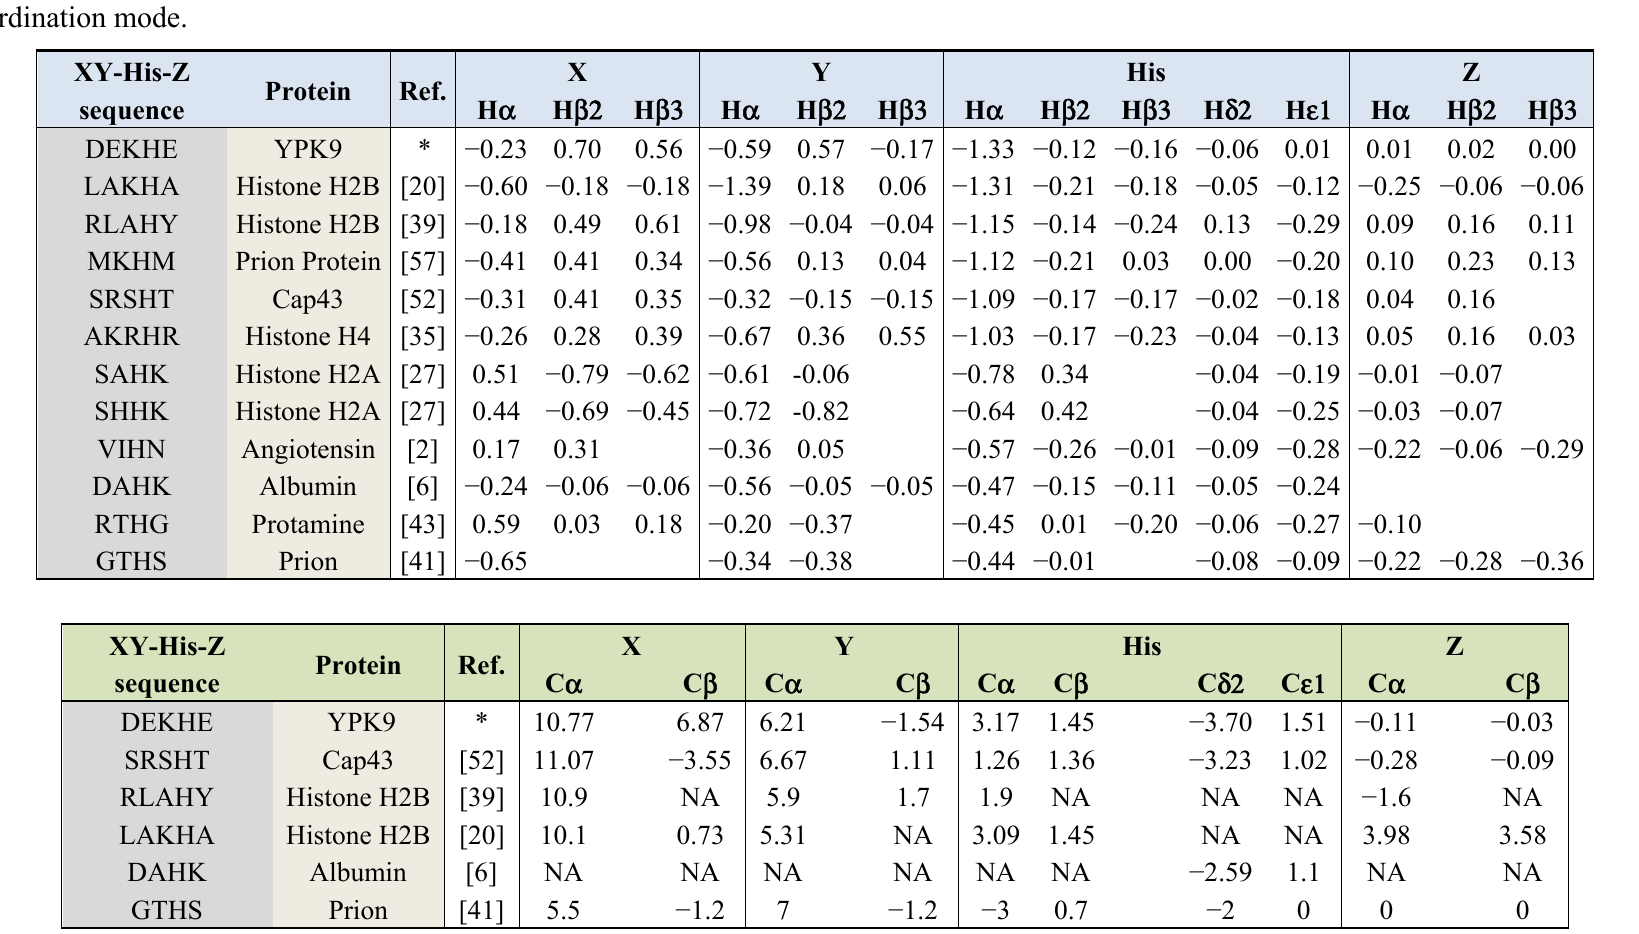
− δ , ppm) of selected analogous sequence with Ni(II) bound in a 4N based holo apo